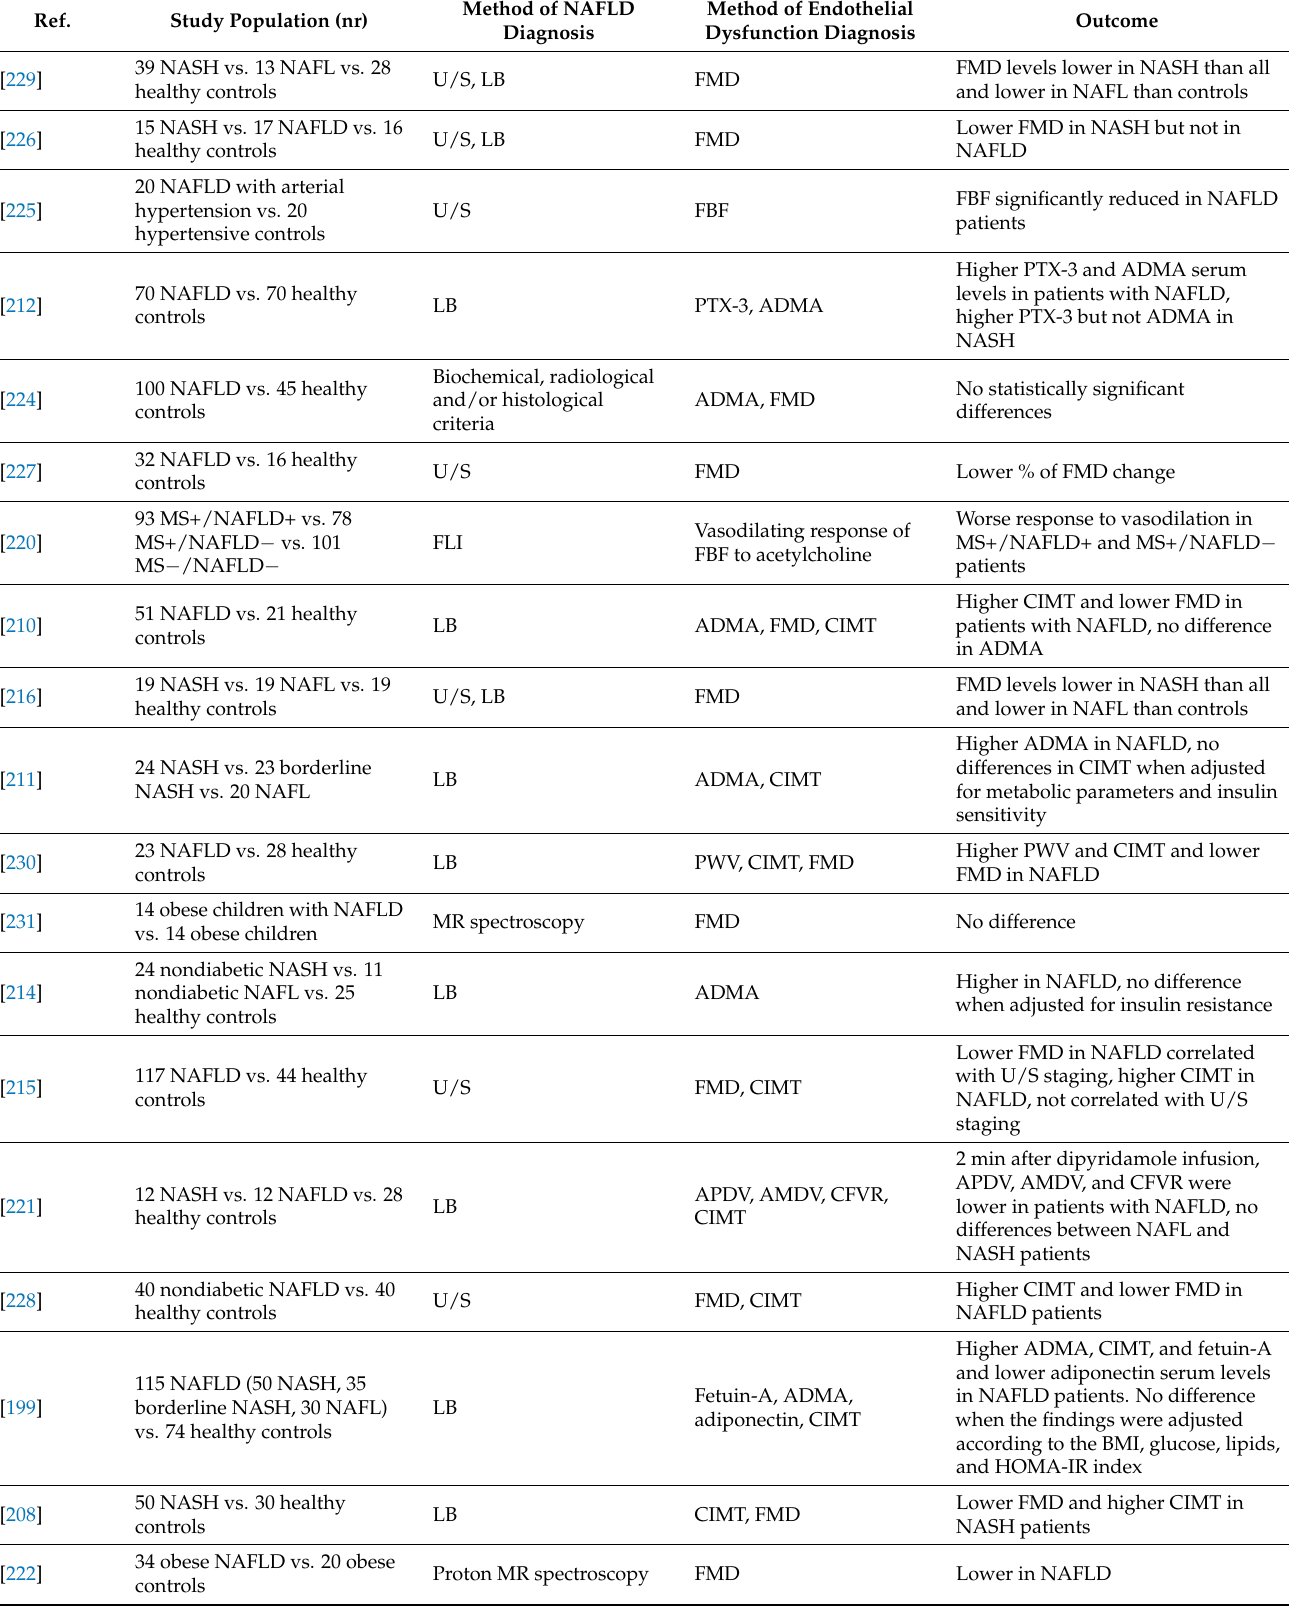
Table 2. Main studies regarding endothelial dysfunction in patients with